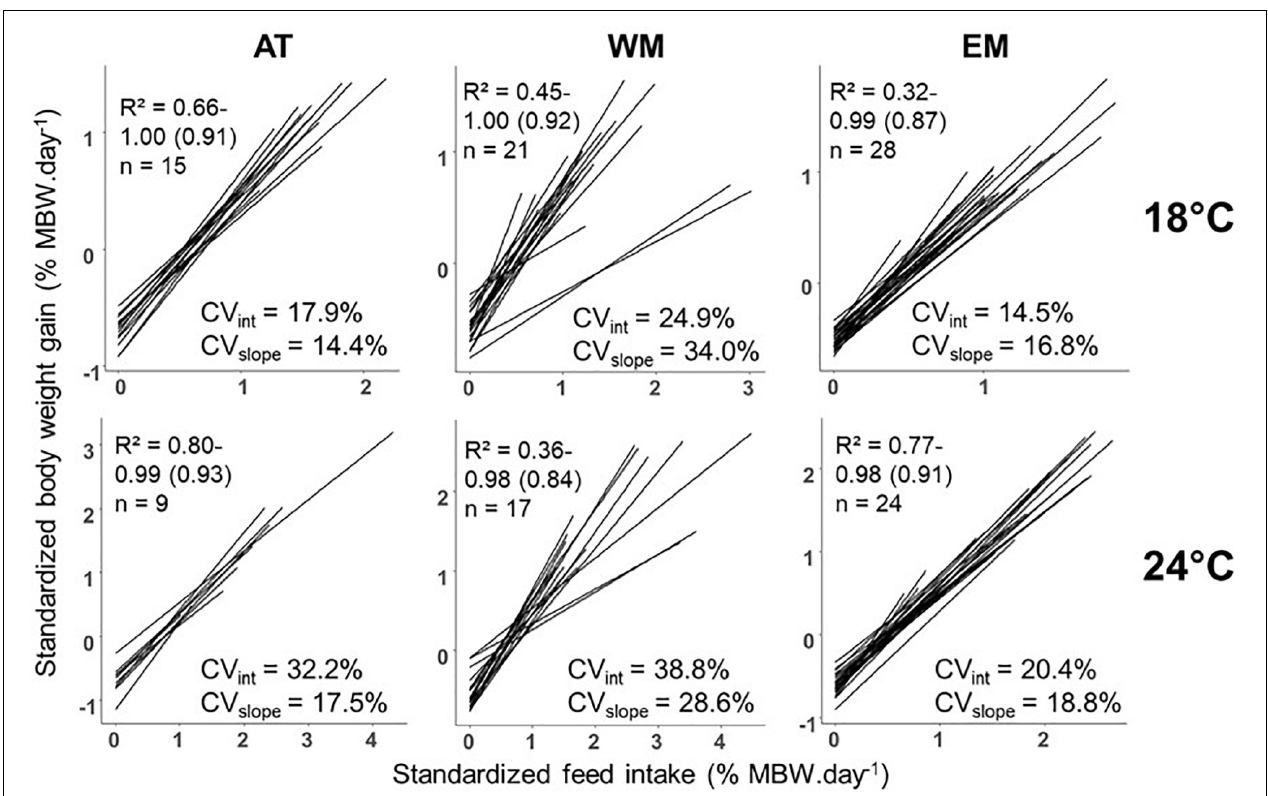
FIGURE 3 | Linear relationships between body weight gain and feed intake, standardized to metabolic body weight (MBW), at individual level within the different population by temperature combinations. The three populations are from Atlantic Ocean (AT), West Mediterranean sea (WM), and East Mediterranean sea (EM). Standardized body weight gain and feed intake are expressed in % of MBW per day. Parameters presented within each combination are the minimum, maximum and average of the R -squared ( R 2 ) of the various linear relationships, the number of individuals (n) and the coefficients of variation of intercept (CV int ) and slope (CV slope